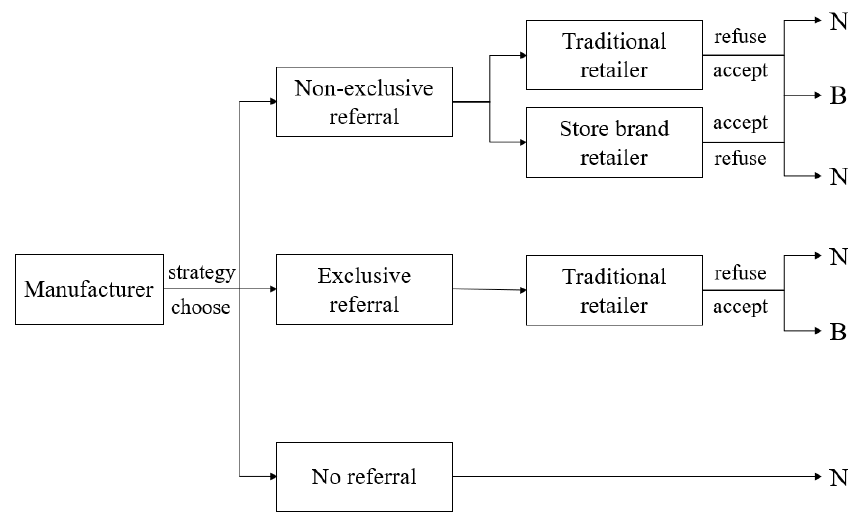
Figure 1. The process of the manufacturer’s referral strategy.